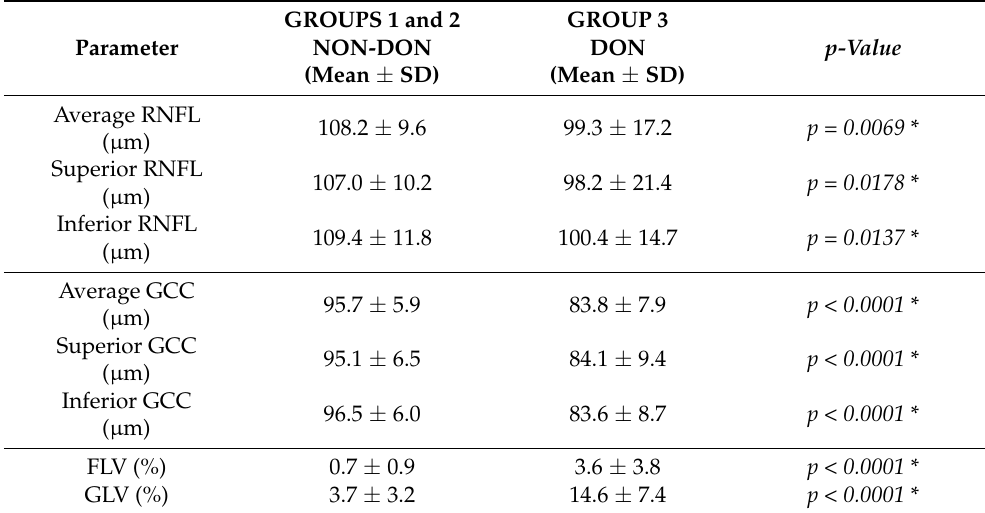
Table 4. A comparison of optical coherence tomography (OCT) parameters between GO patients with no clinical evidence of DON (Groups 1 and 2) and patients with confirmed DON (Group